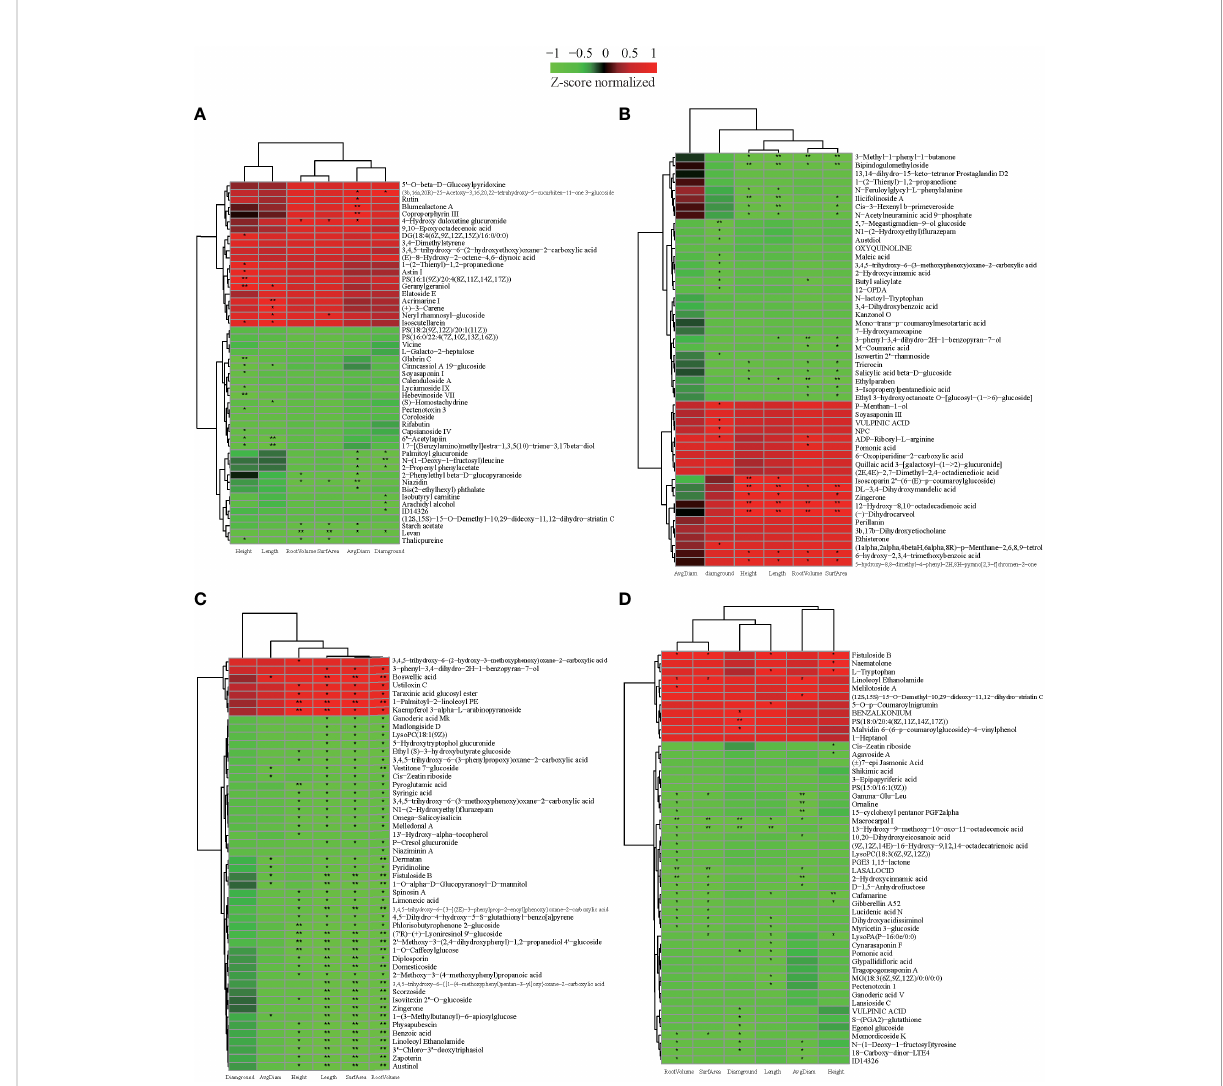
FIGURE 6 The correlation between metabolites and characteristics of the growth of the seedling. (A) The heatmap of top 50 expression abundant metabolites in CL3. (B) The heatmap of top 50 expression abundant metabolites in CL4. (C) The heatmap of top 50 expression abundant metabolites in CL40. (D) The heatmap of top 50 expression abundant metabolites in CL53. Height: seedling height. Diaground: ground diamter. Length: total root length. Surface: root surface. Avgdiam: average diameter. *. Signi fi cantly correlated at the P < 0.05 level; **. Highly signi fi cantly correlated at the P < 0 .01